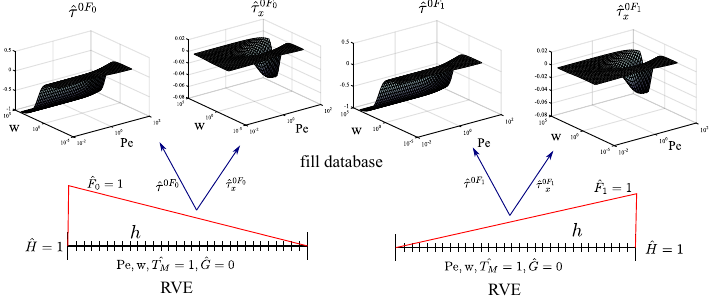
Fig. 5 A graphical description of the actual P-DNS methodology for 1D TADRS problems. To fill the database, N Pe × N w × (2 + np ) RVE problems were solved. This offline work is done once and used online to solve any 1D TADRS coarse scale problem. In this example, the number of points to discretize the source is np =